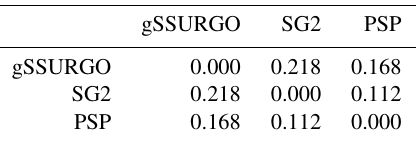
Table 9. The Jensen–Shannon distance between co-occurrence vec- tors